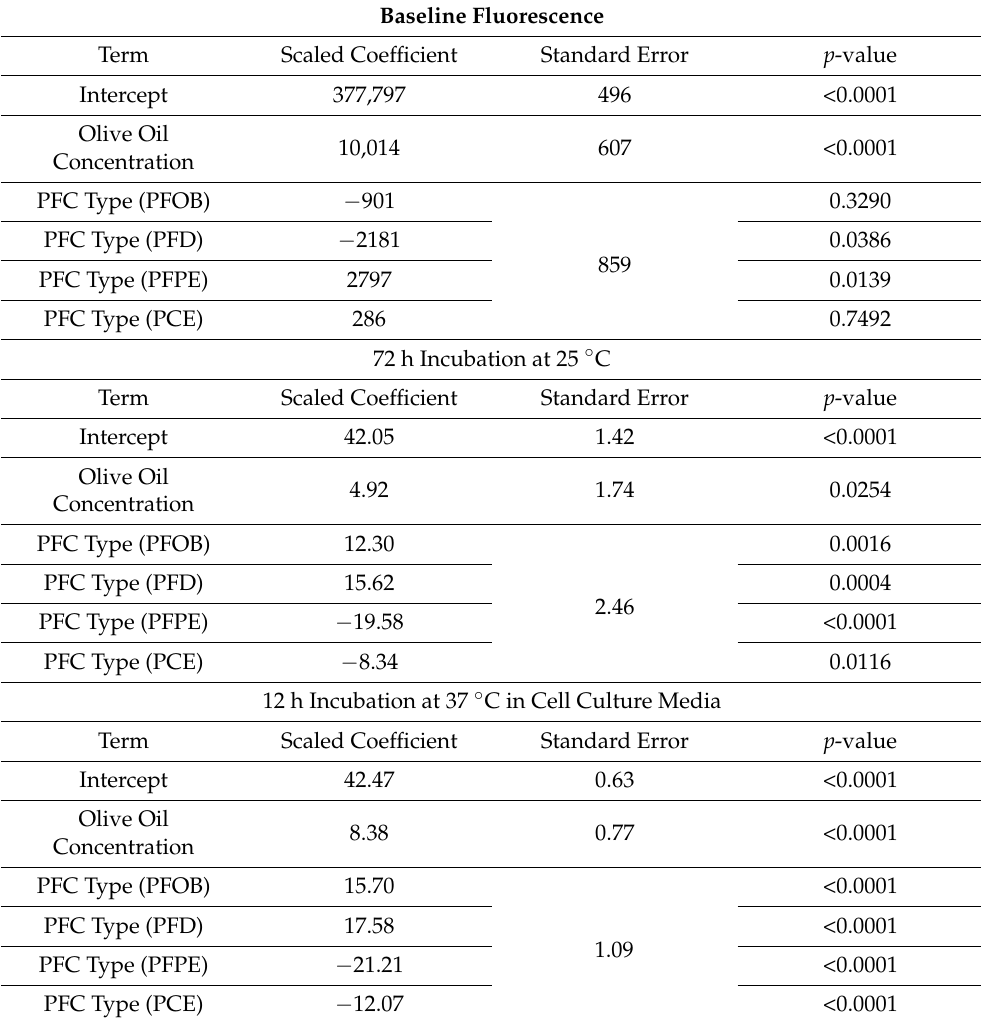
Table 5. Parameter scaled coefficients, standard errors, and p -values for MLR models developed to predict nanoemulsion fluorescence signal (top), nanoemulsion percent fluorescence signal loss after 72 h incubation at 25 ◦ C (center), and nanoemulsion percent fluorescence signal loss after 12 h incubation in cell culture media at 37 ◦ C